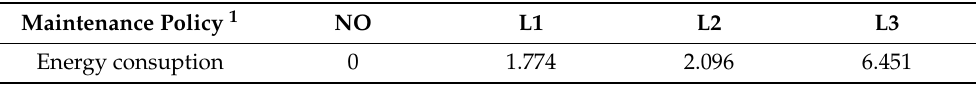
Table 2. Initial energy consumption of different maintenance policies in MW within one cycle of the time window of the